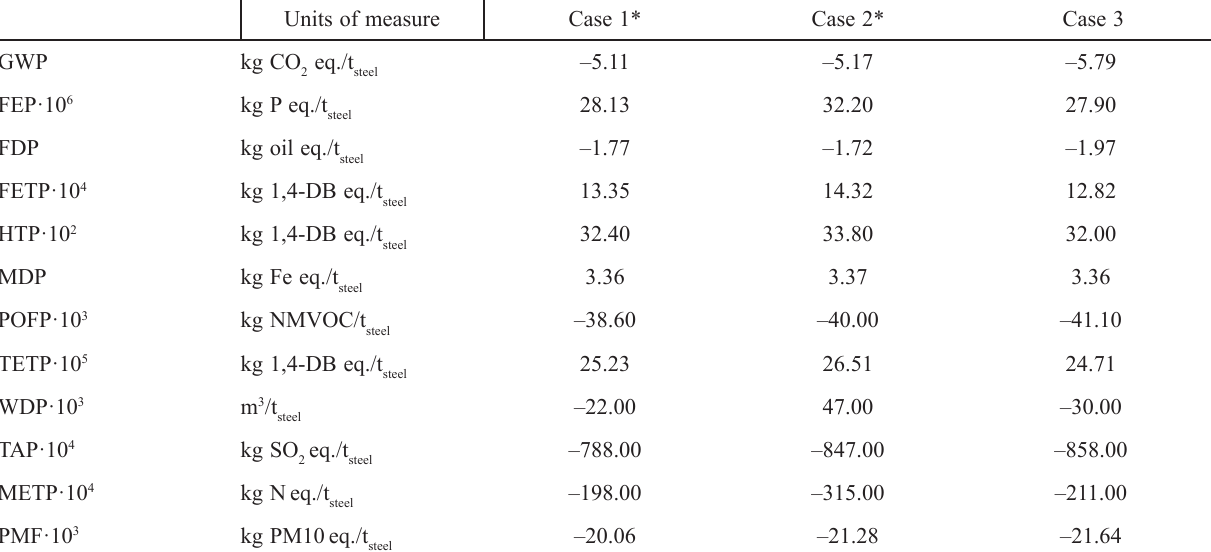
Table 9 – LCIA results for Case 1*, 2*, and 3